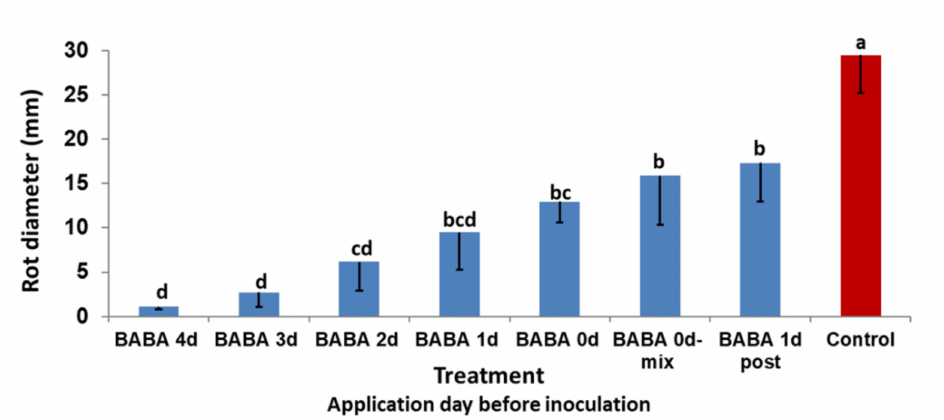
Figure 3. Inhibition of AFR development caused by A. alternata f. sp. mali in detached apple fruits treated with BABA at various days before or after inoculation. In treatment ‘BABA 0 d-mix’, a mixture of BABA with conidial suspension was used for inoculation. The fruit rot diameter produced at 13 days post inoculation in each inoculation site is shown. Bars represent the standard error of the mean. Different letters on columns indicate significant differences between treatments ( p < 0.05, Fisher’s LSD K-ratio t -test).